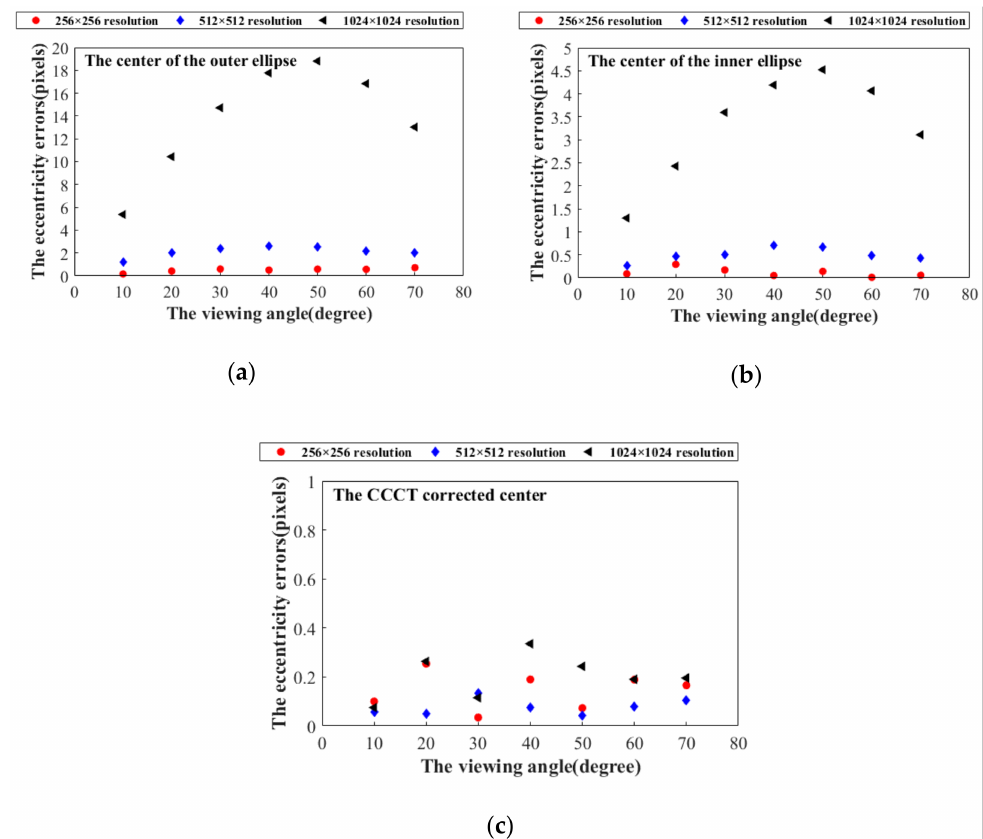
Figure 15. ( a , b ): The eccentricity errors of the outer and inner ellipses’ centers obtained by fitting method; ( c ) The results after correction by our method 10 ◦ .